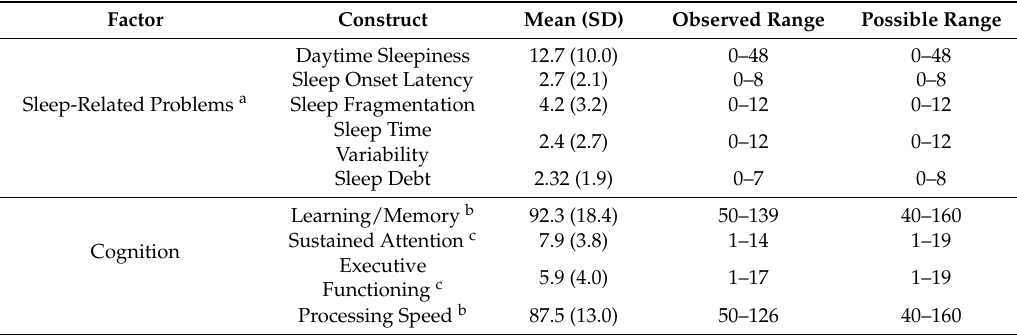
Table 5. Descriptive Statistics for Sleep-Related Problems and